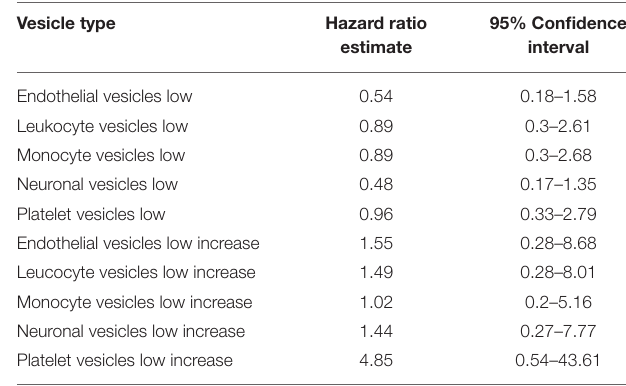
TABLE 4 | Adjusted effect on the Barthel Index and the 95% Confidence interval of each vesicle at baseline and their dynamic from the mixed model. Vesicle type